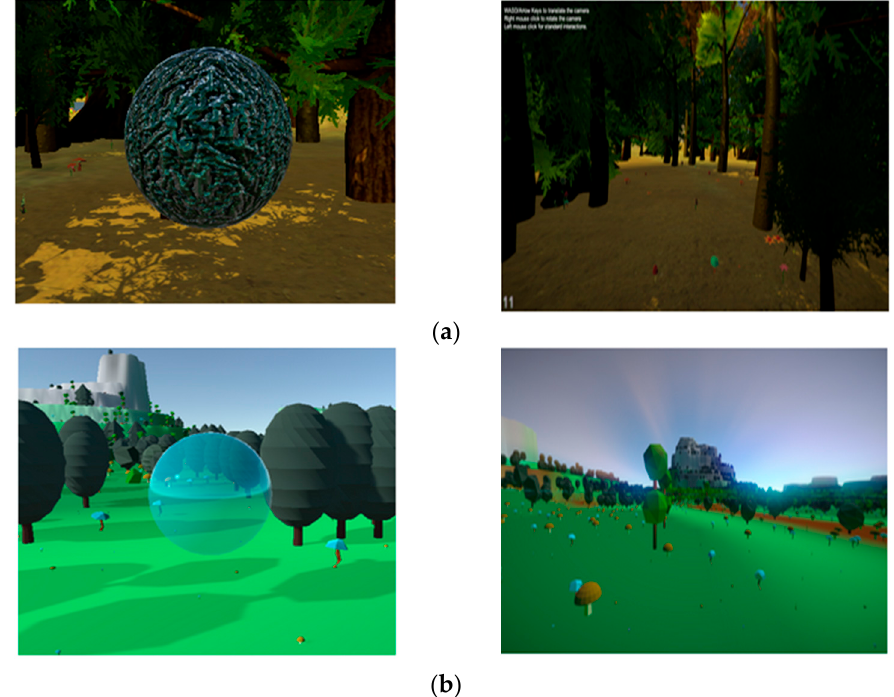
Figure 2. Representation of designed virtual environments: ( a ) realistic and ( b ) dreamlike.